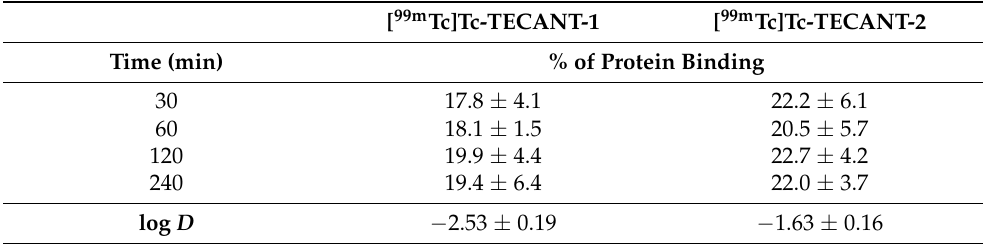
Table 1. Protein binding and log D of [ 99m Tc]Tc-TECANT-1 and [ 99m Tc]Tc-TECANT-2.